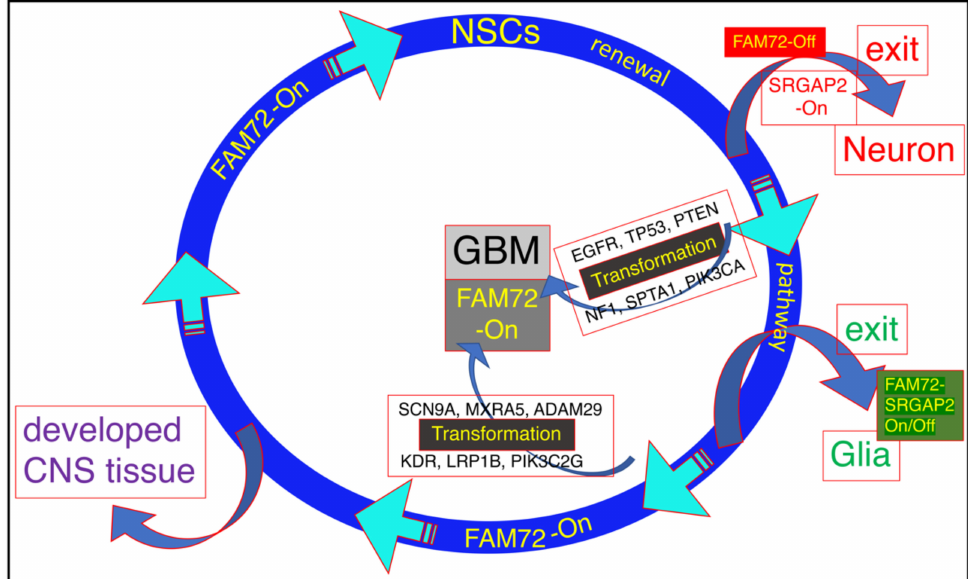
Figure 2. Overview of the |-SRGAP2–FAM72-| master gene expression in GBM [12]. As long as FAM72 remains in the on modus, NSCs keep proliferating. For neuronal differentiation and brain plasticity, FAM72 needs to be switched off to allow SRGAP2 activation and brain development. The activity of the |-SRGAP2–FAM72-| master gene expression during glia cell differentiation is less clear. Since glia cells have the capacity to proliferate, FAM72 might be switched on or off [13–15]. Eventually, mutations in GBM-specific driver genes: epidermal growth factor receptor (EGFR), tumor protein p53 (TP53), phosphatase and tensin homolog (PTEN), neurofibromin 1 (NF1), spectrin alpha, erythrocytic 1 (SPTA1) and phosphatidylinositol-4,5-bisphosphate 3-kinase catalytic subunit alpha (PIK3CA) or sodium voltage-gated channel alpha subunit 9 (SCN9A), matrix remodeling associated 5 (MXRA5), a disintegrin and metalloprotease domain 29 (ADAM29), kinase insert domain receptor (KDR), phosphatidylinositol-4-phosphate 3-kinase catalytic subunit type 2 gamma (PIK3C2G), and low-density lipoprotein receptor related protein 1B (LRP1B) induce NSC transformation into cancer stem cells (CSCs) while FAM72 is still in the on modus